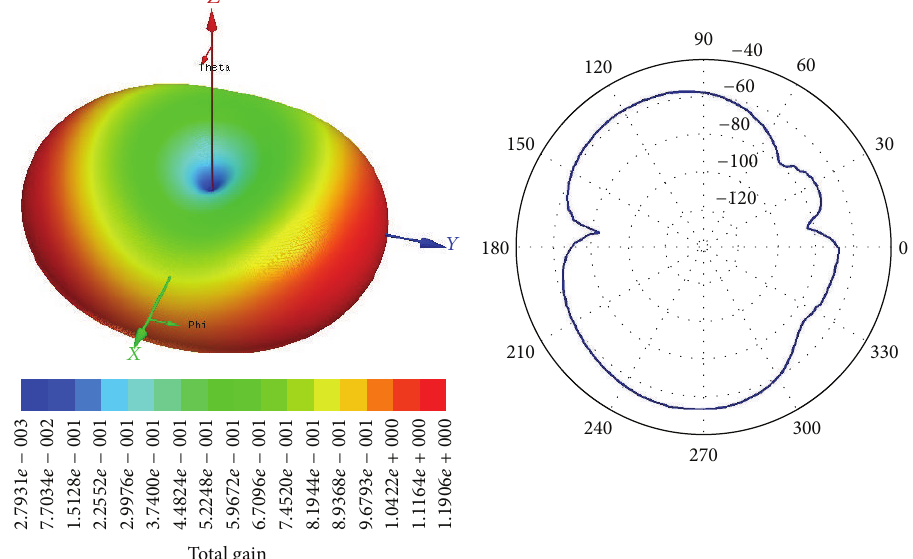
Figure 10: Radiation pattern graphic (measurement), single turn spiral.